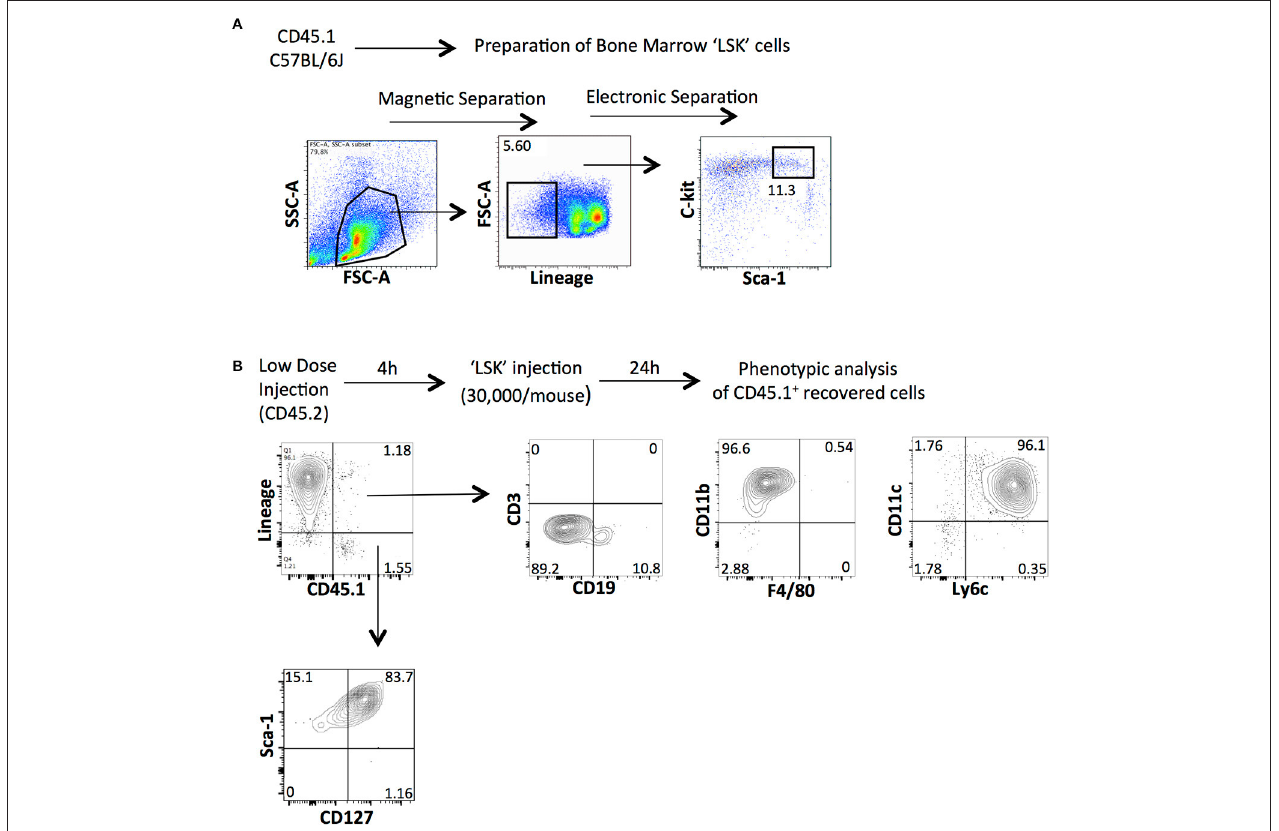
FIGURE 4 | Intraperitoneal injection of BM-derived HSPCs contributes to the emergence of innate lymphoid-like cells in the peritoneal cavity of low-dose zymosan-injected mice. (A) Total bone marrow cells from congenic CD45.1 mice underwent magnetic and electronic cell separation in order to get pure hematopoietic stem cells (LSK). First, cells were selected based on the positive expression of CD117 (c-kit) and then stained for Lineage and Sca-1. A population of Lineage − c-kit + Sca-1 + was finally electronically sorted out. (B) CD45.2 C57BL/6J mice were injected intraperitoneally with a low-dose of zymosan and 4h later the same recipients got 30,000 of LSK cells (i.p injection). Twenty-four hours post-injection, cells were recovered from the peritoneal cavity of injected mice and stained for several markers of mature immune cells (including CD3e, CD19, CD11b, F4/80, CD11c, and Ly6c) or markers for innate lymphoid-like cells such as Lineage, Sca-1 and CD127. (One representative experiment is shown from 3 independent